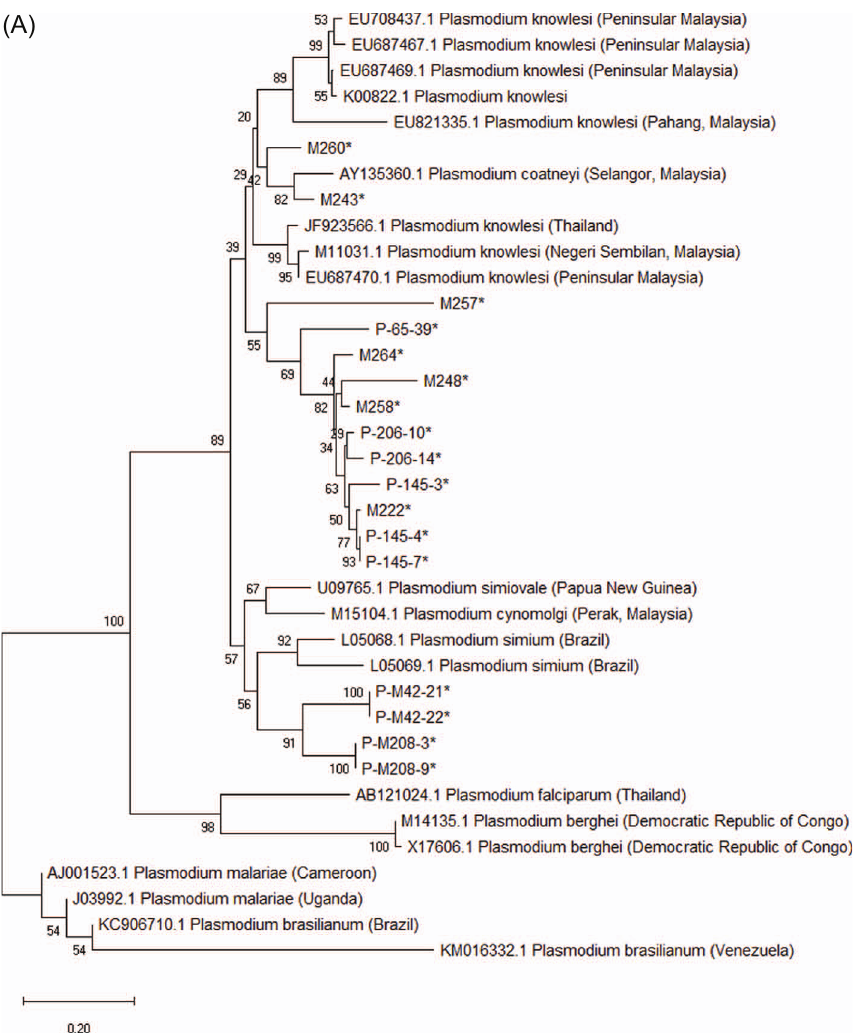
Figure 4. Phylogenetic tree based on CSP sequences of Plasmodium spp. All P. knowlesi CSP sequences obtained in this study are annotated as M257, M208 (P-M208-9-M13F, P-M208-3-M13F), M42 (P-M42-21-M13F, P-M42-22-M13F), M145 (P-145-7-M13F, P-145-4-M13F, P- 145-3-M13F), M258, M206 (P-206-14-M13F, P-206-10-M13F), M65 (P-65-39-M13F), M260, M243, M222, M248, M264, and M234. The phylogenetic tree was constructed using the NJ method in MEGA7 (A), Bayesian (B) method using MrBayes software, and Maximum likelihood method (C) in MEGA-X. The percentages of replicate trees in which the associated isolates cluster together in the bootstrap test (1000 replicates) are shown next to the branches. The tree was drawn to scale, with branch length in the same unit as those of the evolutionary distances used to infer the phylogenetic tree. The evolutionary distances were computed using the Kimura 2-parameter and are in the units of the number of base substitutions per